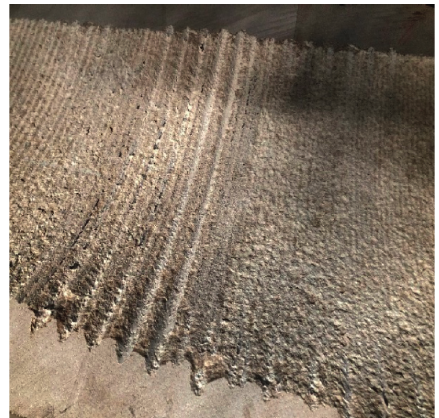
Figure 6: Single pick cutting